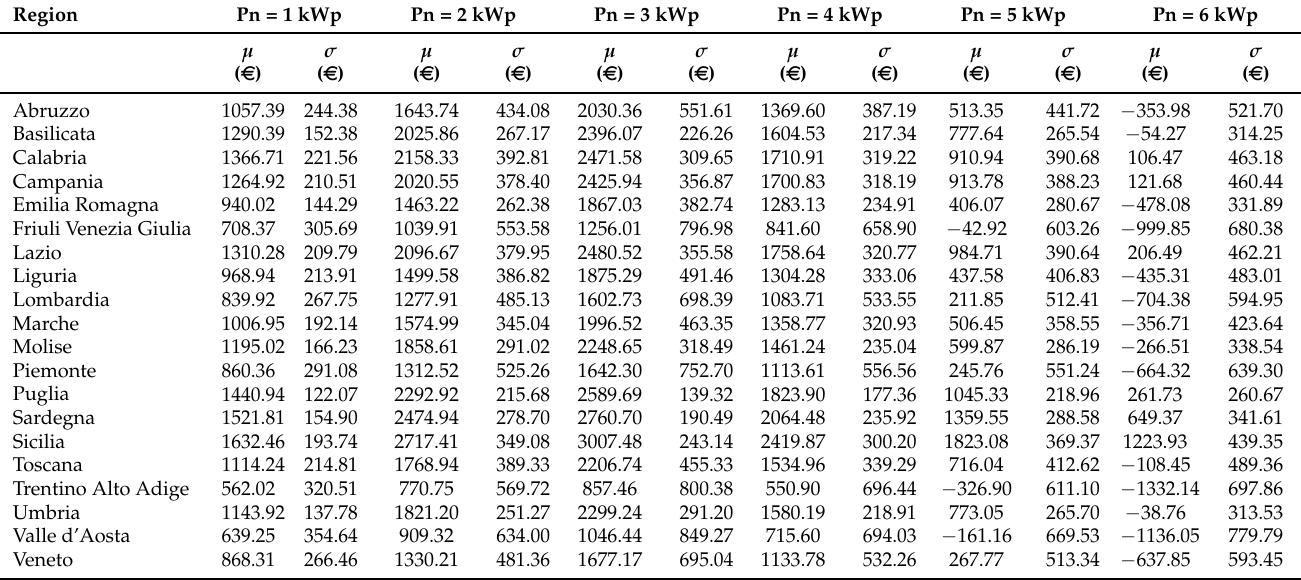
Table 18. NPV for E L = 4000 kWh without